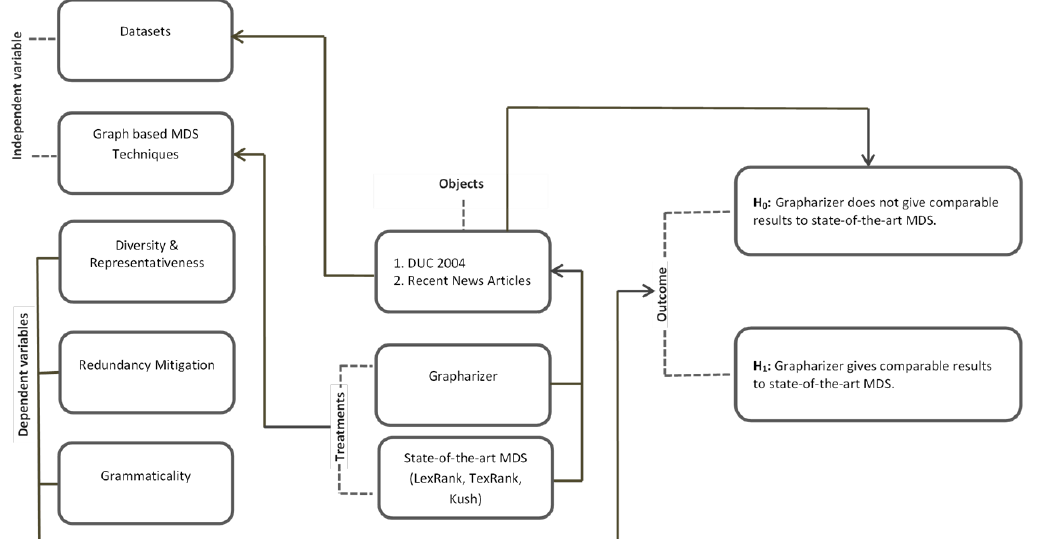
Figure 2. The Experimental Design of Grapharizer.